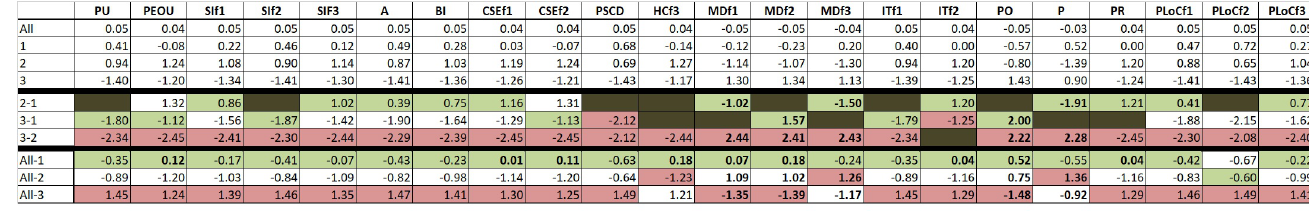
Figure 5. The table describes the scaled differences of the average values of all the variables. For a given variable (a column), green values indicate the highest difference in absolute value, and red values indicate the smallest. Dark brown cells indicate non-meaningful differences for a variable in a pair of